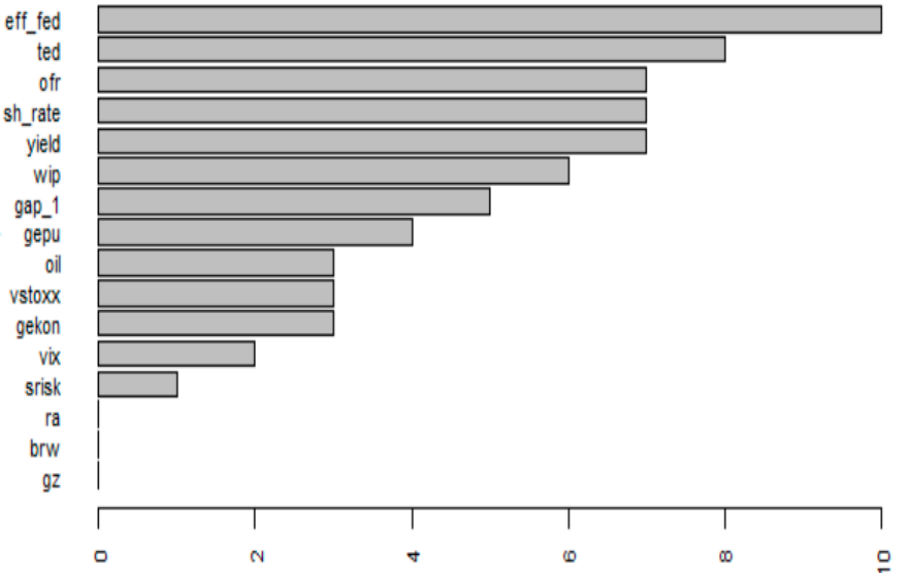
Figure 1. Variable importance ranking for 2000Q1:2007Q3.